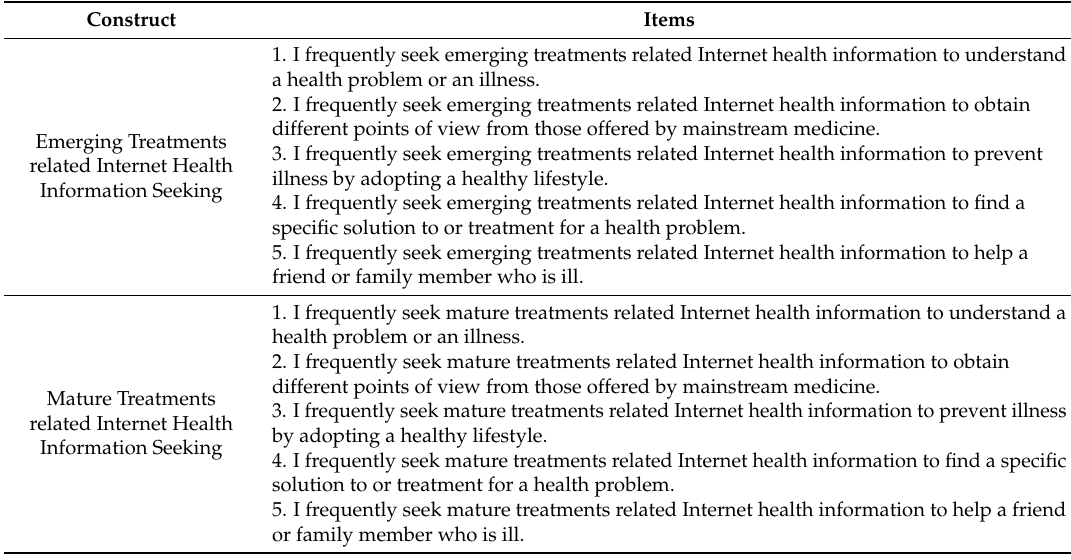
Table A1. Measurement